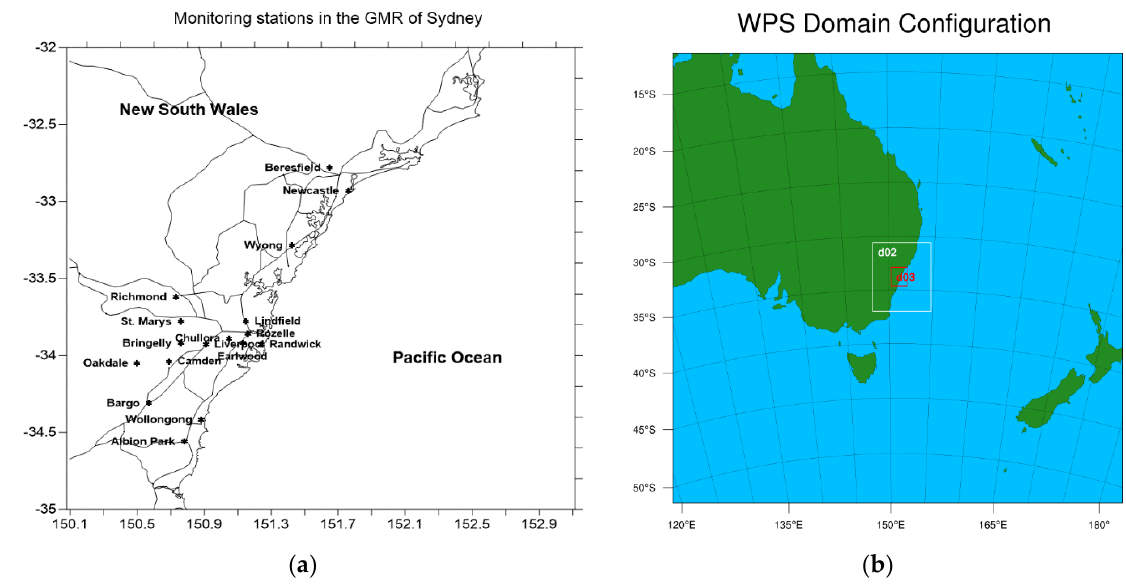
Figure 2. ( a ) Department of Planning, Industry, and Environment (DPIE) air quality monitoring stations and major roads; ( b ) the three-nested domains consisting of the outer domain (d01), inner domain (d02), and innermost domain (d03). The d02 domain covers most of New South Wales (NSW), while the d03 domain covers the greater metropolitan region (GMR) of Sydney.